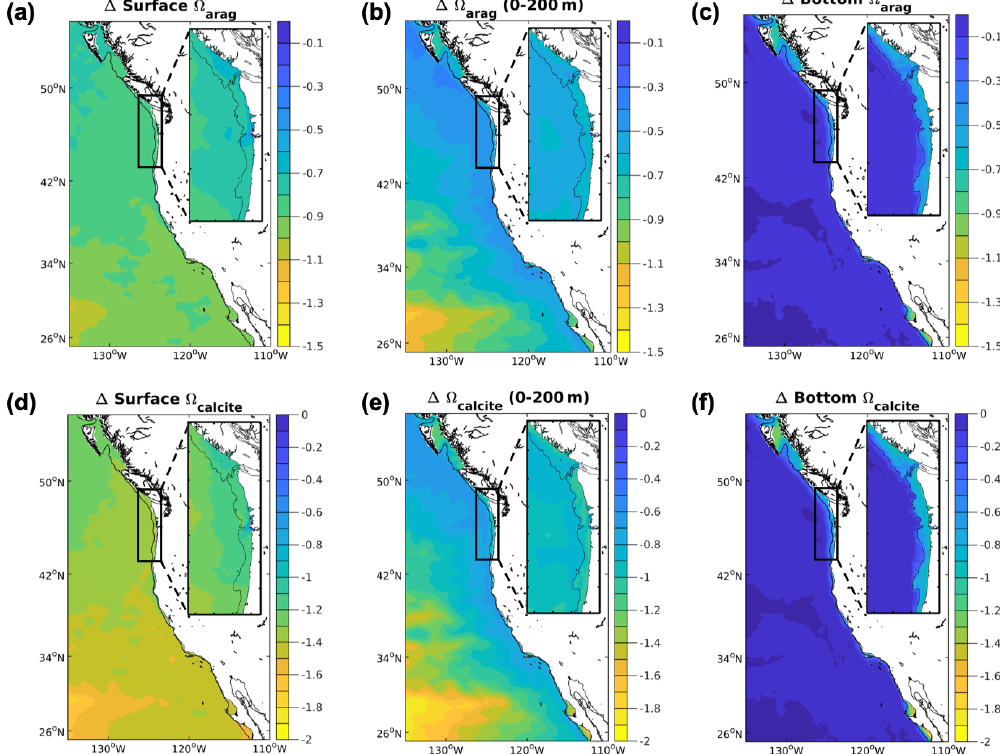
Figure 5. Projected (cid:127) changes in the CCS. Differences between climate stressor variables (cid:127) in the future and the base/present conditions for the 12km (CCS-wide, full panel) and 1.5km projections (N-CCS, inset). (a) Surface (cid:127) arag , (b) depth-averaged (cid:127) arag over the upper 200m, (c) bottom (cid:127) arag , (d) surface (cid:127) calcite , (e) depth-averaged (cid:127) calcite over the upper 200m, and (f) bottom (cid:127) calcite . Positive values indicate a change that is greater in the future than the base/present condition, and negative values indicate lower values in the future than the base/present condition depicted in Fig.